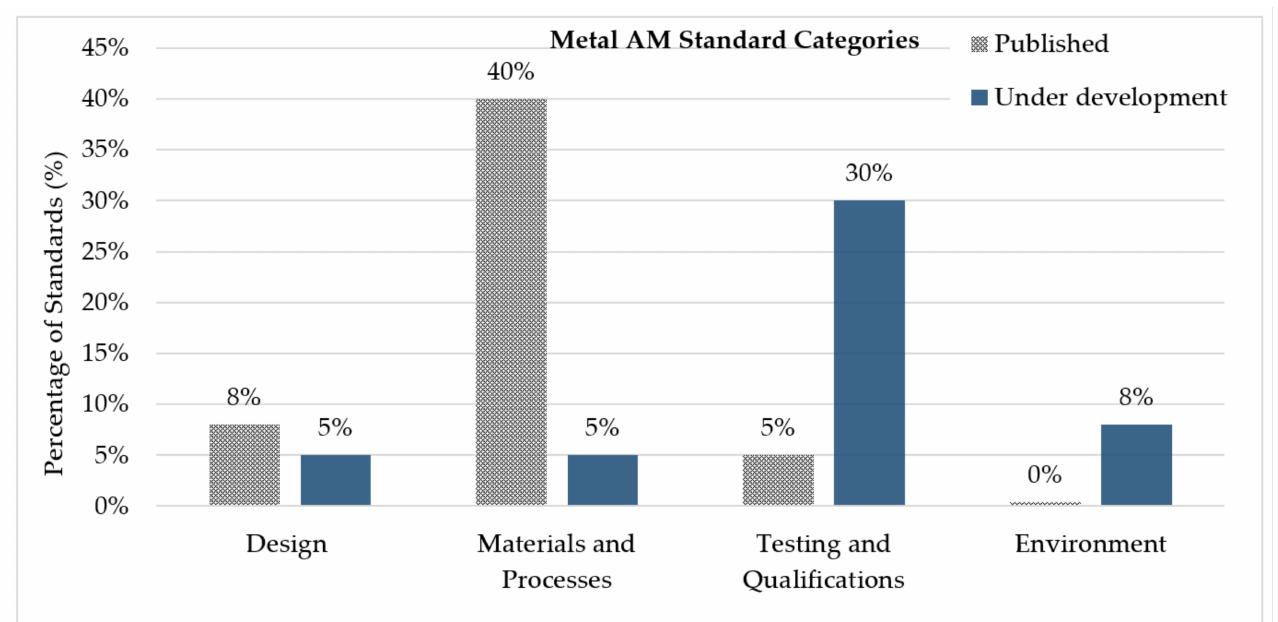
Figure 12. Current and under development metal AM 40 identified